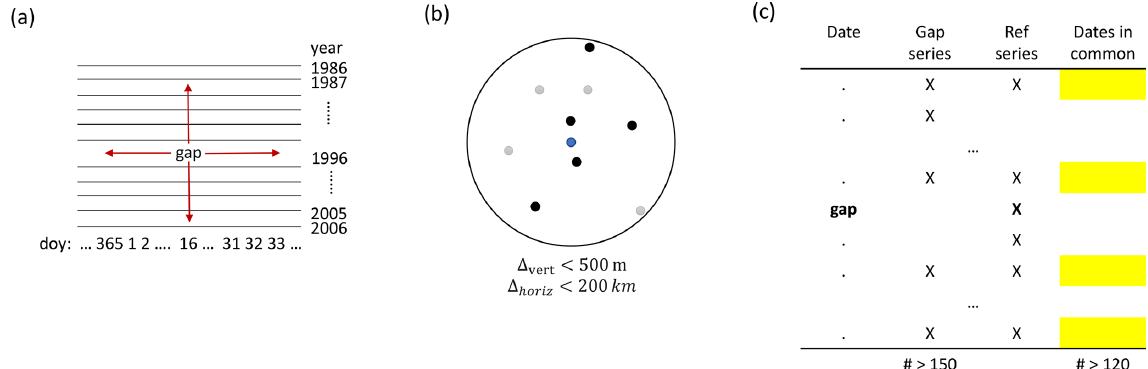
Figure A2. Visualization of some steps of the gap-filling algorithm. Panel (a) shows how the window data in the gap series around the gap is determined (step 1); doy is day of the year. Panel (b) shows the selection of potential reference series by horizontal and vertical distance (step 2). Panel (c) shows how common dates for gap and reference series are identified (step 3); the dates come from the window in (a)